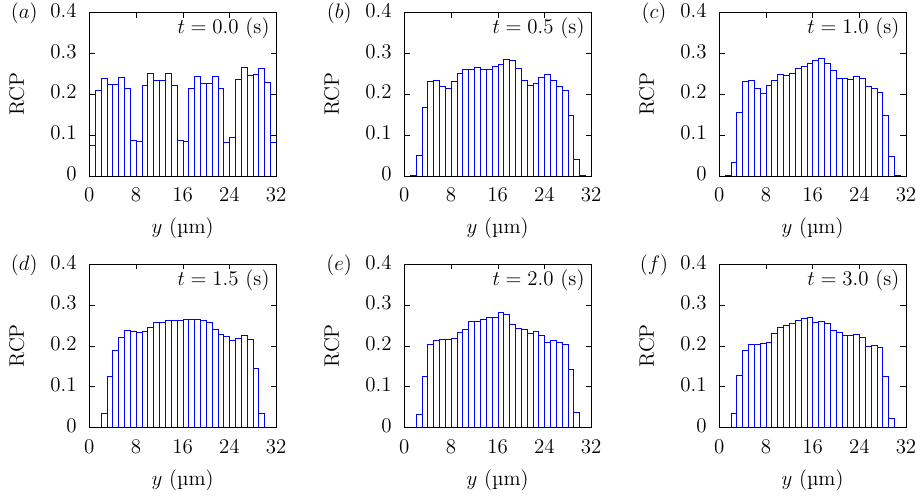
Figure 5. RBC Concentration Profiles (RCPs) in a straight channel of 224 × 32 × 32 µ m for ˙ γ w = 972 s − 1 , Ht = 20% at ( a ) t = 0, ( b ) t = 0.5, ( c ) t = 1.0, ( d ) t = 1.5, ( e ) t = 2.0, and ( f ) 3.0 s. Each graph corresponds to the results in Figure